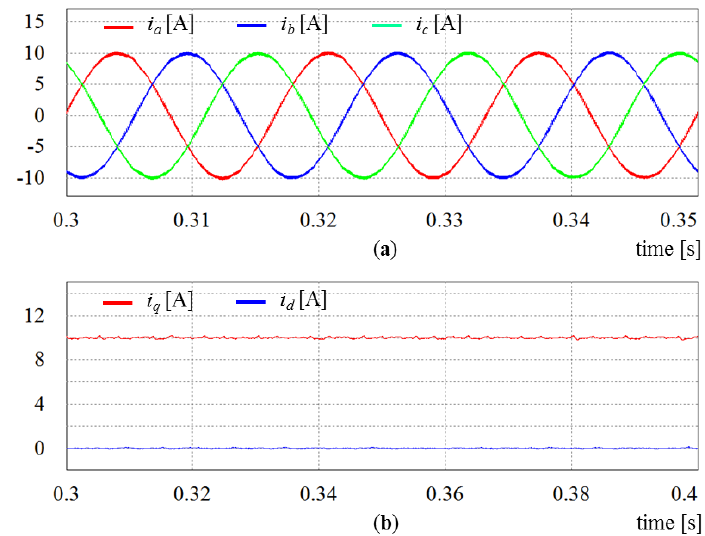
Figure 9. Inverter currents of the conventional proportional-integral (PI) decoupling controller under the ideal grid voltages: ( a ) phase-currents; and ( b ) q- axis and d- axis currents. Energies 2016 , 9 , 190